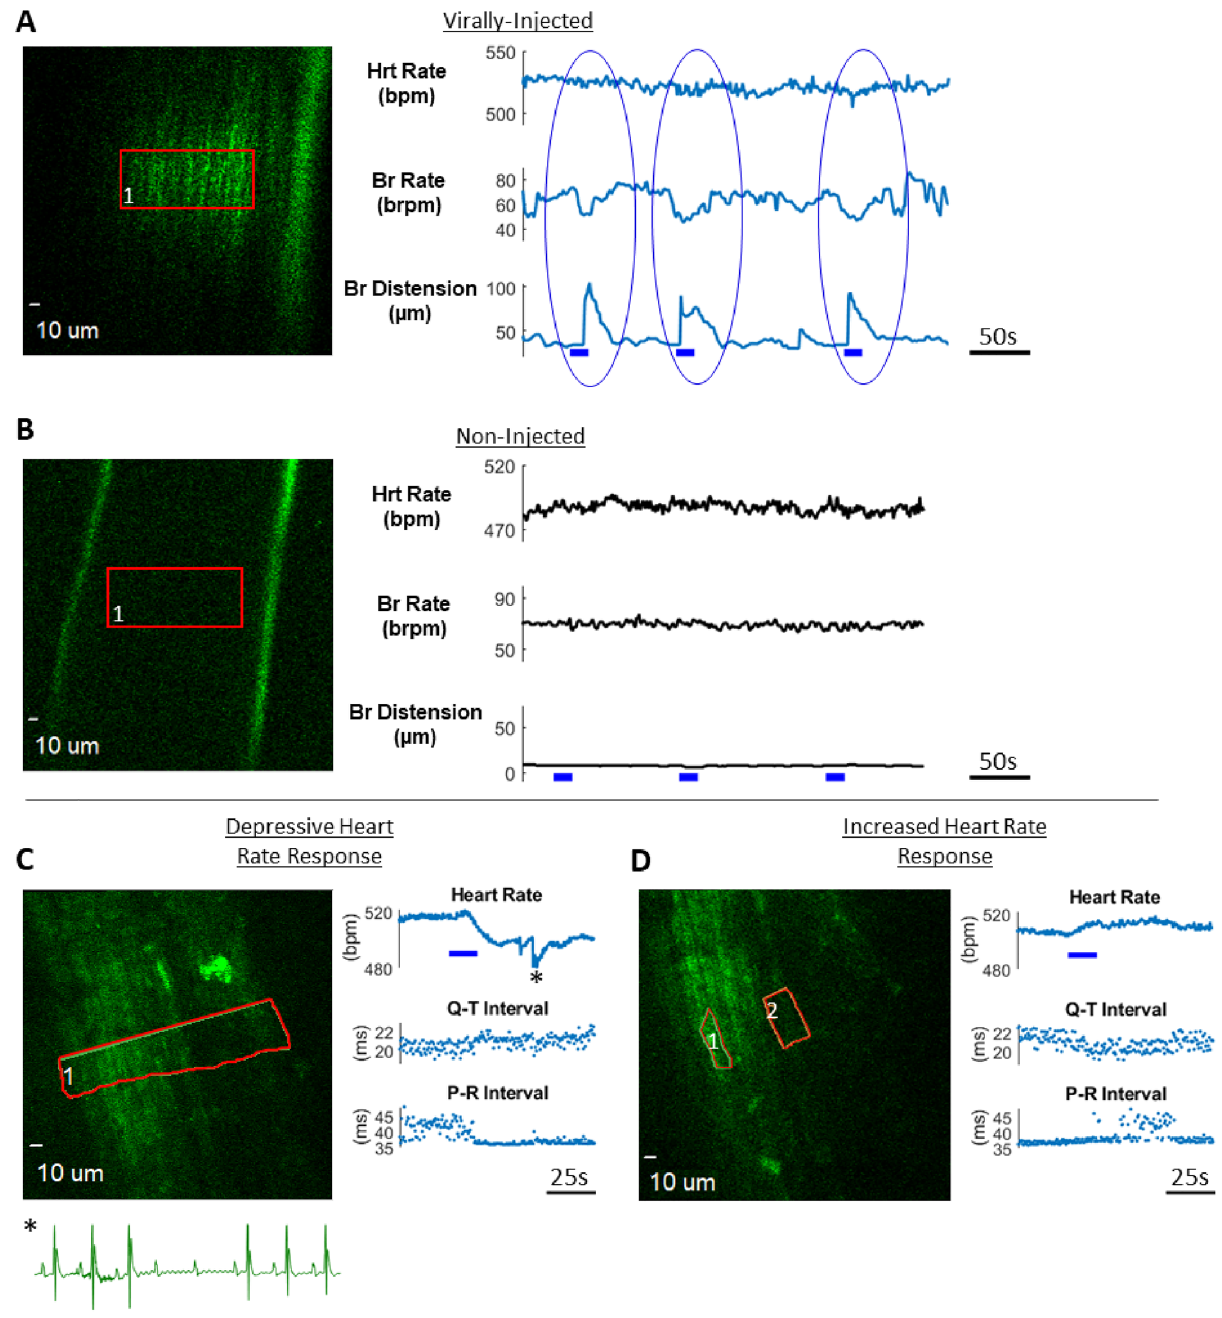
Figure 5. Two-photon holographic photostimulation in the cervical vagus nerve in mice infected with rAAV2- retro in the heart and control. ( A ) 920 nm photoexcitation (red ROI) in AAVrg-CAG-ChR2(h134R)-tdTomato- injected mouse elicited robust response in breath rate and distension (blue bar: 20 Hz pulses, 5 ms pulse duration, 0.014 mW/µm 2 unmodulated intensity). ( B ) Same photoexcitation in non-injected control mouse did not evoke any respiratory or cardiac responses. ( C , D ) 1030 nm photoexcitation in AAVrg-Syn-Chronos-eGFP- injected mouse elicited differential heart response with spatially distinct photoexcitation regions (red ROIs). The broad photoexcitation region in panel C caused a depressive heart rate response that led to heart block (asterisk, see inset) while the excitation profile in panel D caused an increase in heart rate and opposing ECG parameter changes. (blue bar: 20 Hz pulses, 5 ms pulse duration, panel B: 0.12 mW/µm 2 unmodulated intensity and panel C: 0.18 mW/µm 2 unmodulated intensity). (Images were rendered in SlideBook6 software: https ://www.intel ligen t-imagi ng.com/slide